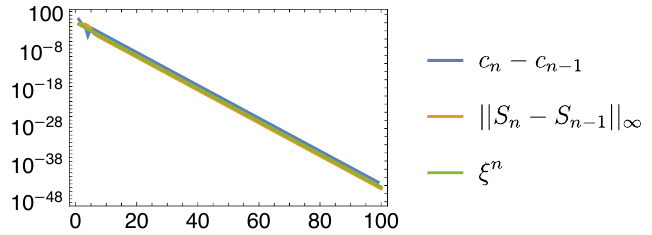
Figure 2 . Convergence of the algorithm is dictated by the spectral radius ξ of the Jacobian. The horizontal axis labels the number of iterations. || . || ments of the discretized S-matrix seen as a vector of the values of the S-matrix, || S Max i =0 ,...,N | S n,i − S n − 1 ,i |